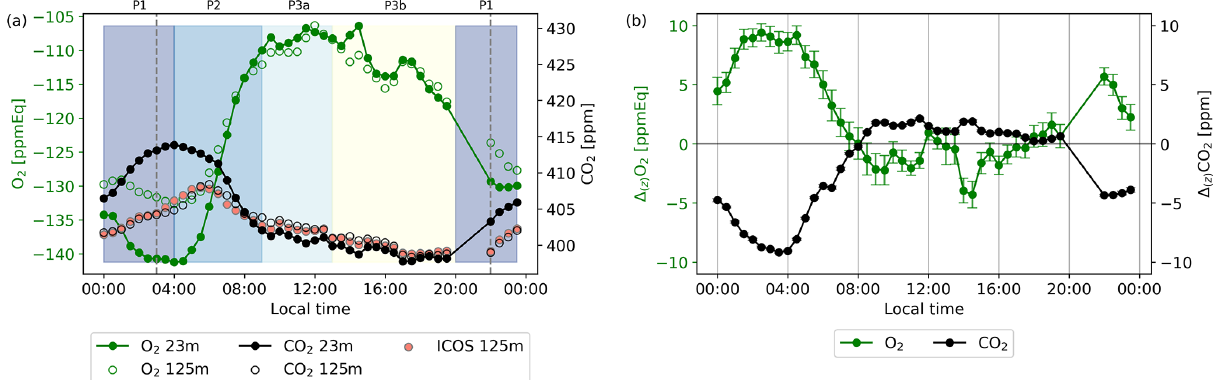
Figure 4. Diurnal cycles in local wintertime (LT; time zone UTC+2) (all times in this paper are given in local time unless stated otherwise) of the O 2 and CO 2 concentrations for the 23 and 125m height levels (a) and the vertical gradient between both levels with the uncertainty of both O 2 and CO 2 of the representative day, taken as the average values of 7 through 12 July 2019 (b) . The CO 2 measurements of the ICOS setup are shown in (a) for comparison with the CO 2 setup measured during our campaigns. The shaded colours indicate the selected different periods when the most dominant processes are the following: stable atmosphere and respiration (00:00–04:00, P1); entrainment, boundary layer growth, and assimilation (04:00–09:00, P2); convective conditions and assimilation (09:00–13:00, P3a); and the same as P3a plus a remaining artefact for the O 2 measurements after the pressure correction as explained in the text (13:00–20:00, P3b). The vertical dotted lines indicate the sunrise (03:00) and sunset (22:00). The error bars in panel (b) are half-hourly standard errors based on the error propagation of the standard errors of the data points in (a) (not shown), which were based on Eq.